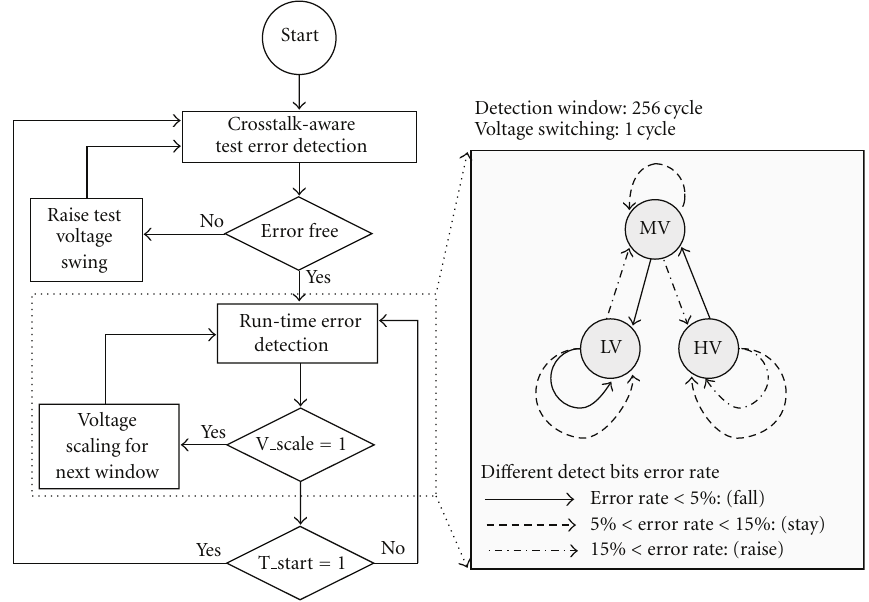
Figure 12: The control policy of self-calibrated voltage scaling technique.